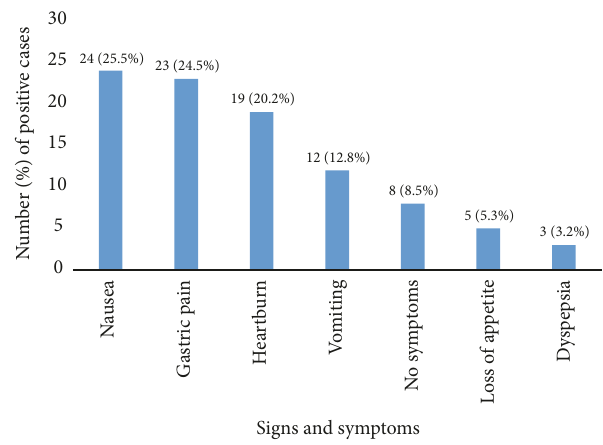
Figure1:Frequencyofsymptomsassociatedwith H.pylori infection among